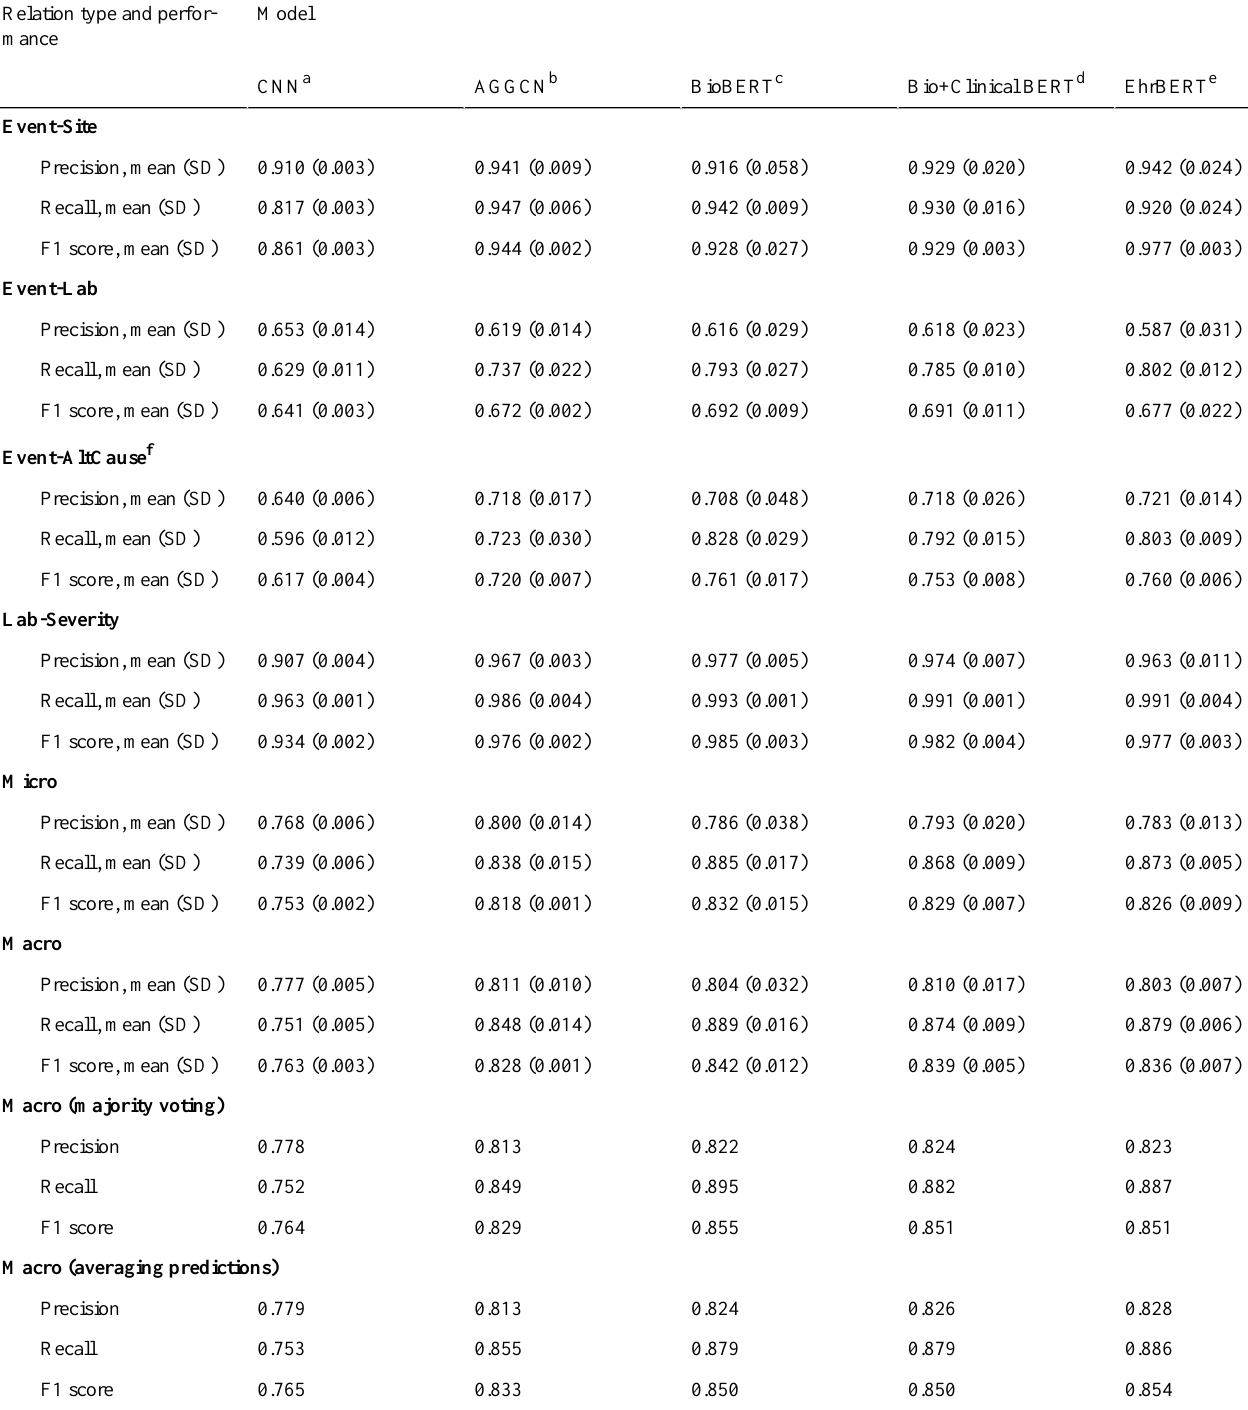
Table 2. Performance comparison of convolutional neural network (CNN), attention-guided graph convolutional network (AGGCN), and Bidirectional Encoder Representations from Transformers–based models